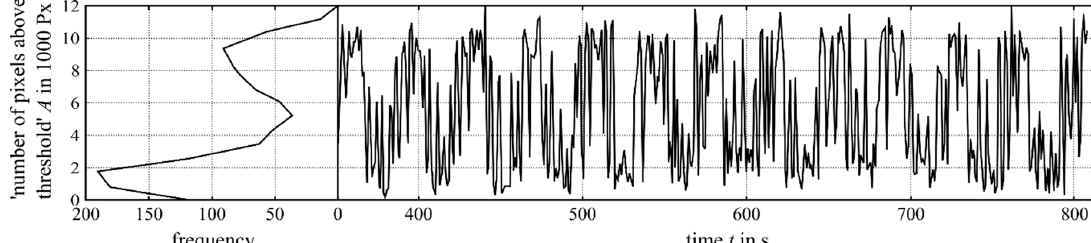
Figure 10. Extract of the NOP (intensity threshold 948 digits) during the variation of the laser power at a laser power of P = 1600 W. The histogram on the left side shows the whole steady state of the experiment.